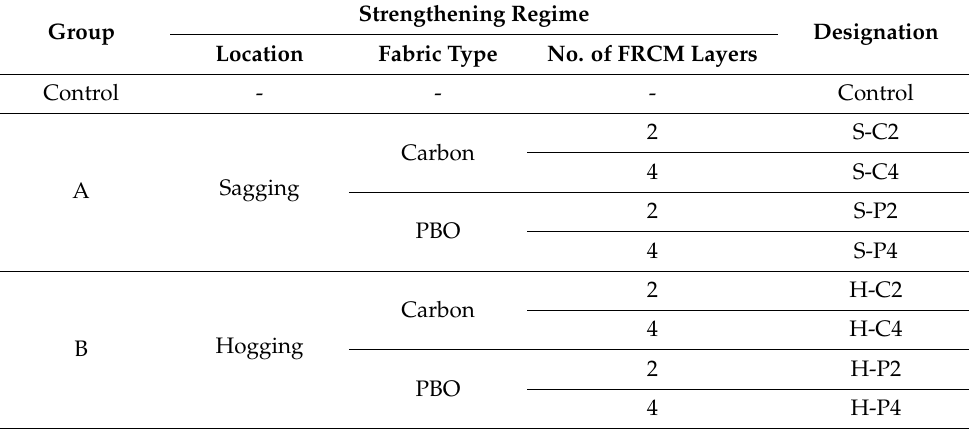
Table 1. Test matrix.